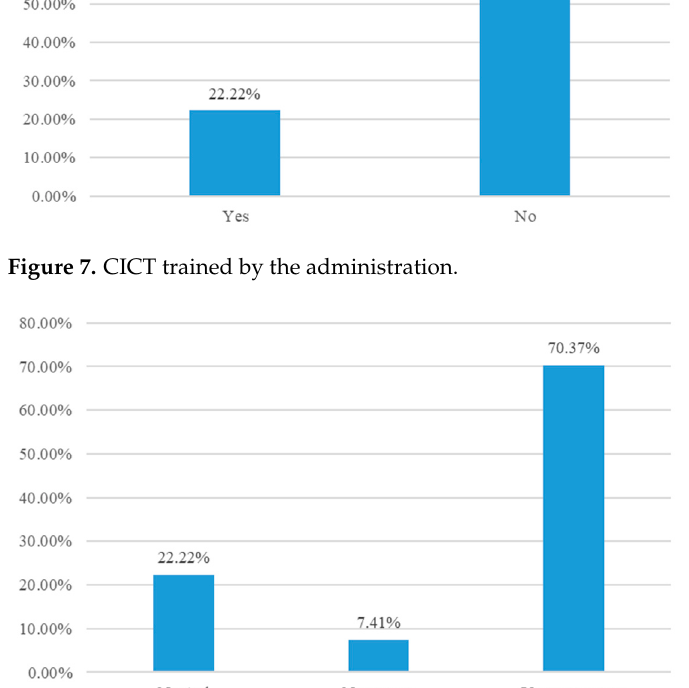
Figure 8. Assessment of the need for the existence of the CICT .